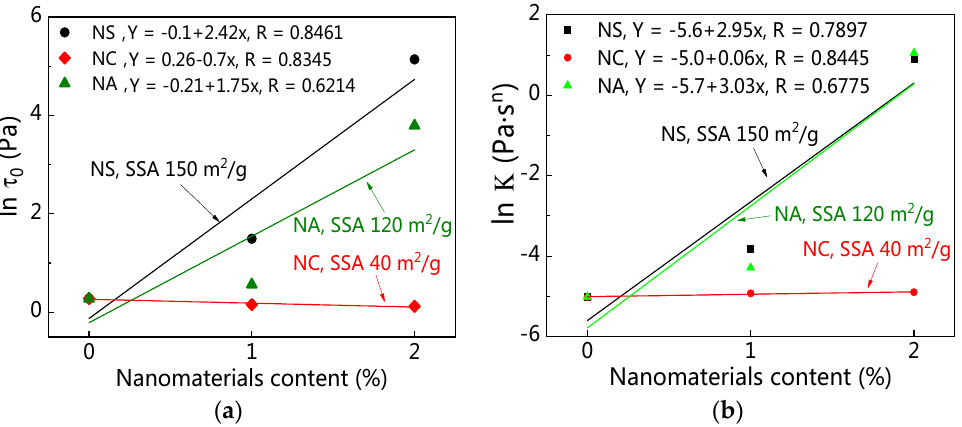
Figure 30. Specific surface area (SSA) and rheological parameters (resting time was 5 min.): ( a ) SSA and τ 0 ; ( b ) SSA and K .